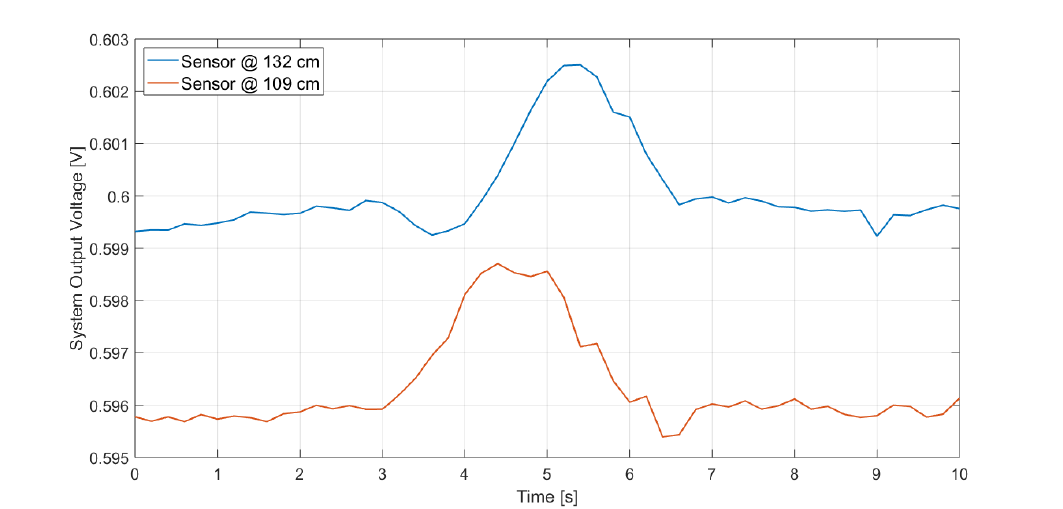
Figure 21. Measurements results in the case of a subject walking at 2.5 m in front of the sensor, for different sensor heights.